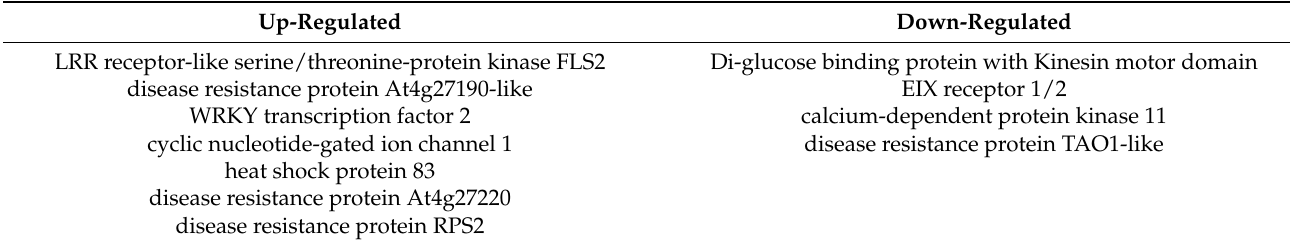
Enzymes were listed according to the differences range from large to